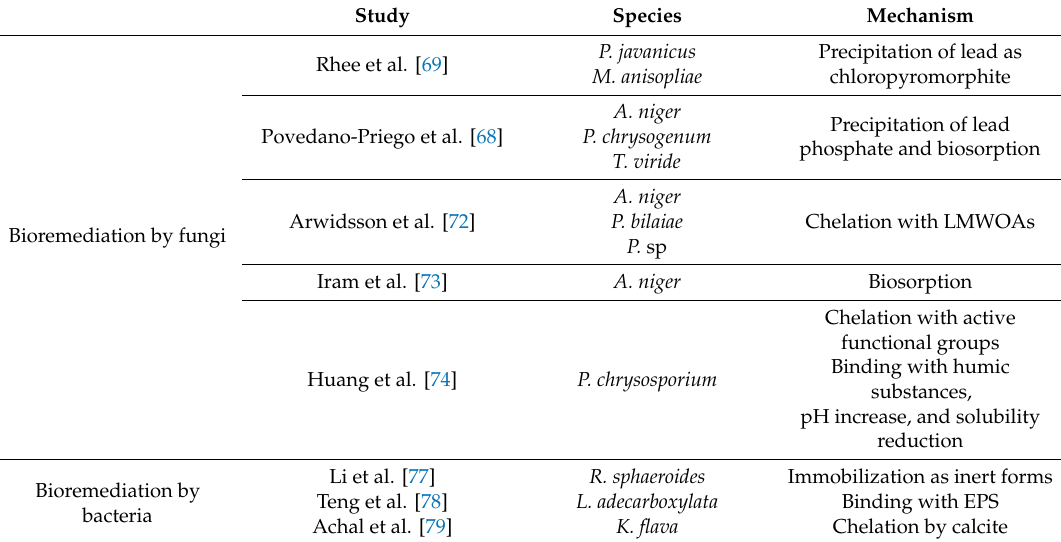
Table 3. Summary table of studies on the bioremediation of lead via fungi and